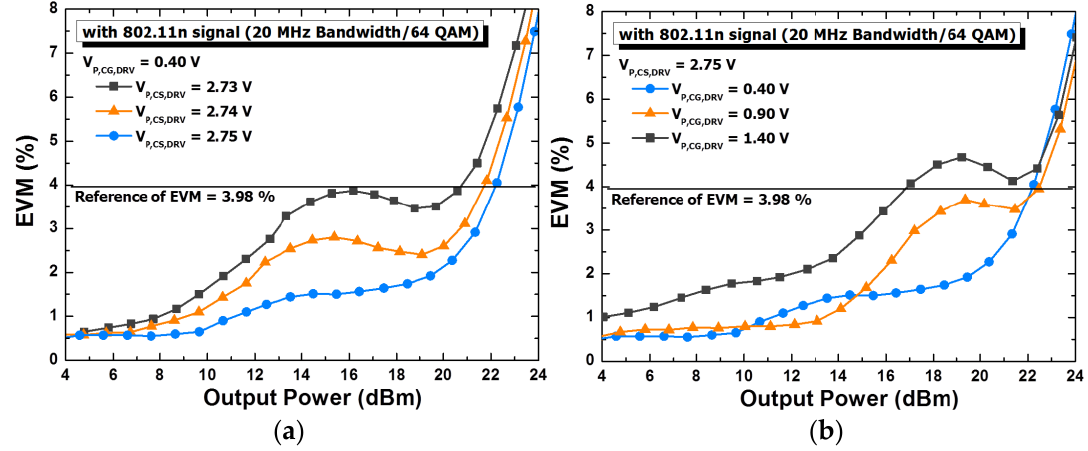
Figure 18. Measured results: error vector magnitude (EVM)3s with 802.11 n modulated signal for the various gate bias values ( a ) V P,CS,DRV , ( b ) V P,CG,DRV .